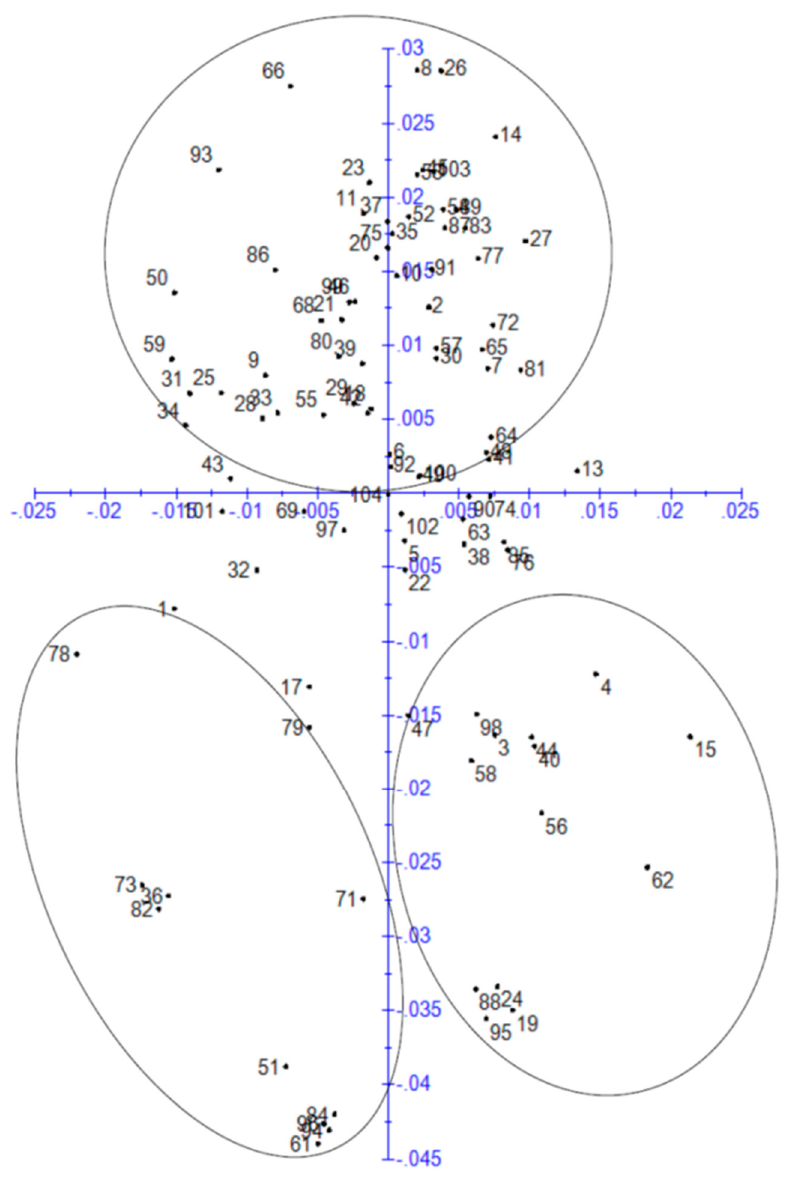
Figure 5. Principal coordinate analysis (PCA) based on genetic distance matrix calculated for 99 Brachiaria ecotypes from Uganda based on 24 microsatellite markers. Percentages of variation explained by PC1 and PC2 were 40.6% and 18.2%, respectively.